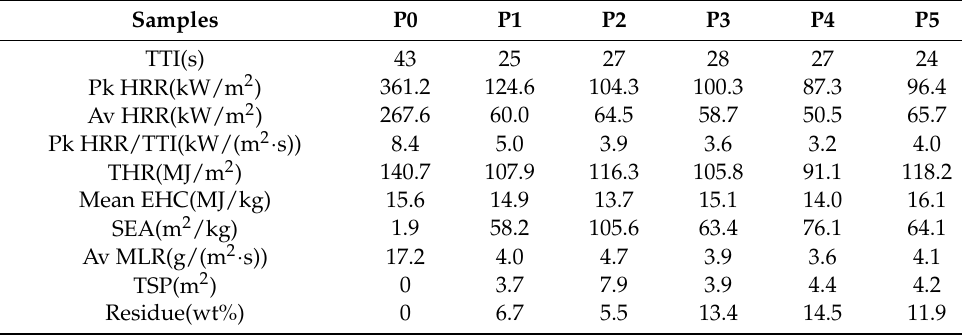
Figure 9. HRR, THR, TSP, and mass loss rate curves of FR-POM composites. Table 6. Cone calorimetric characteristic data of FR-POM composites.